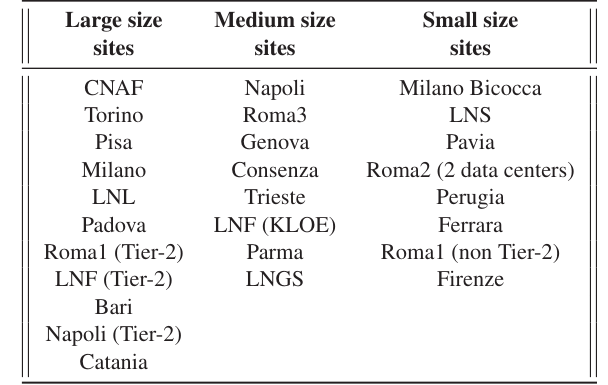
Table 2: INFN sites grouped by